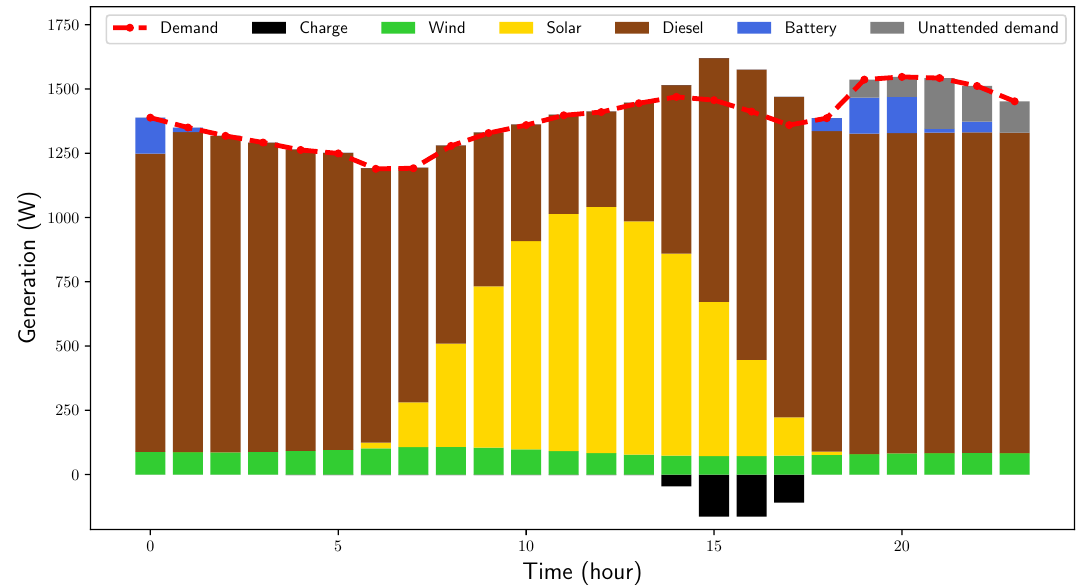
Figure 1. Microgrid load management over the time horizon (24